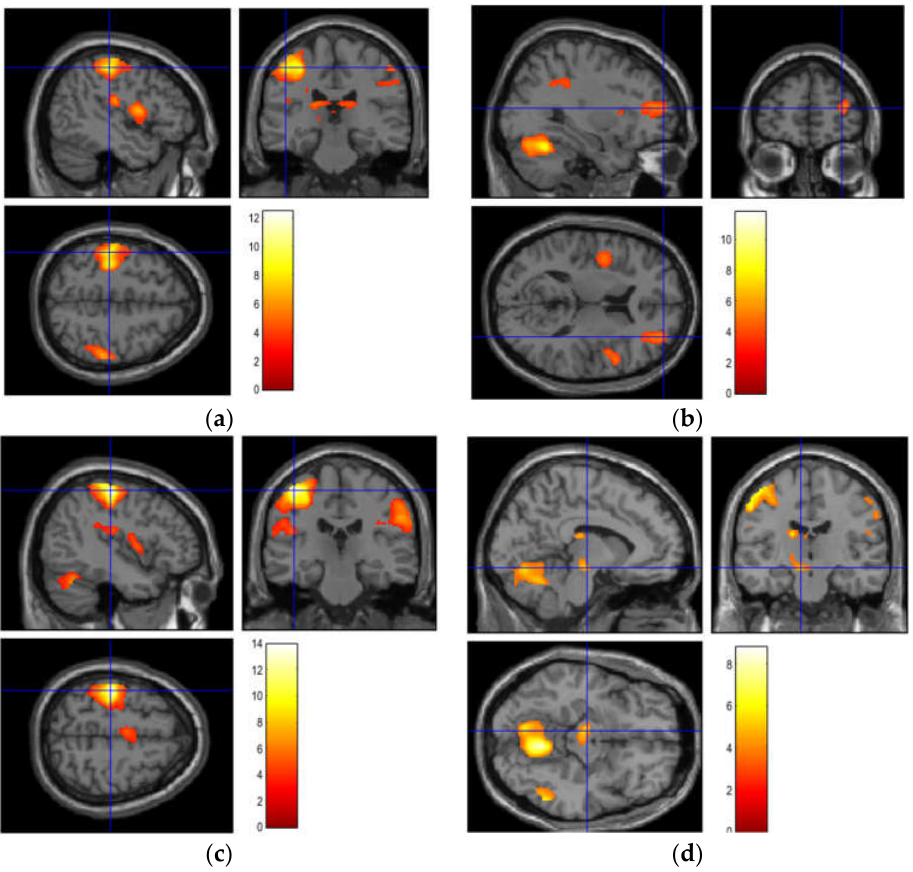
Figure 4. The images of the brain activation while grasping each object. ( a ) Object 1: Left postcentral gyrus ( b ) Object 2: Right middle frontal gyrus; ( c ) Object 3: Left postcentral gyrus; ( d ) Object 4: Left ventral diencephalon